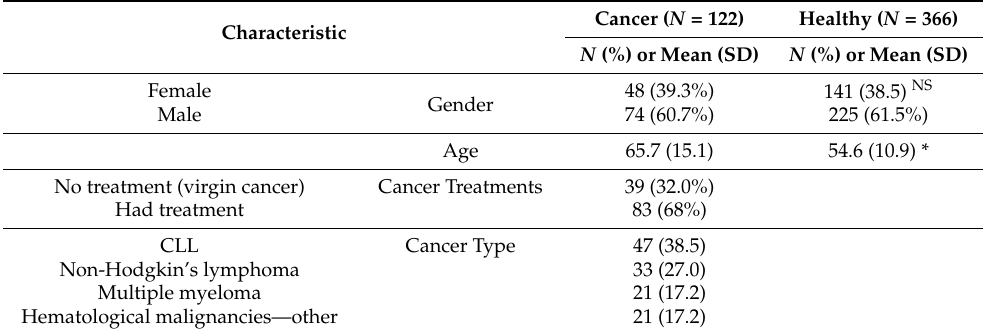
Table 1. Demographic and population characteristics of the participants ( N =